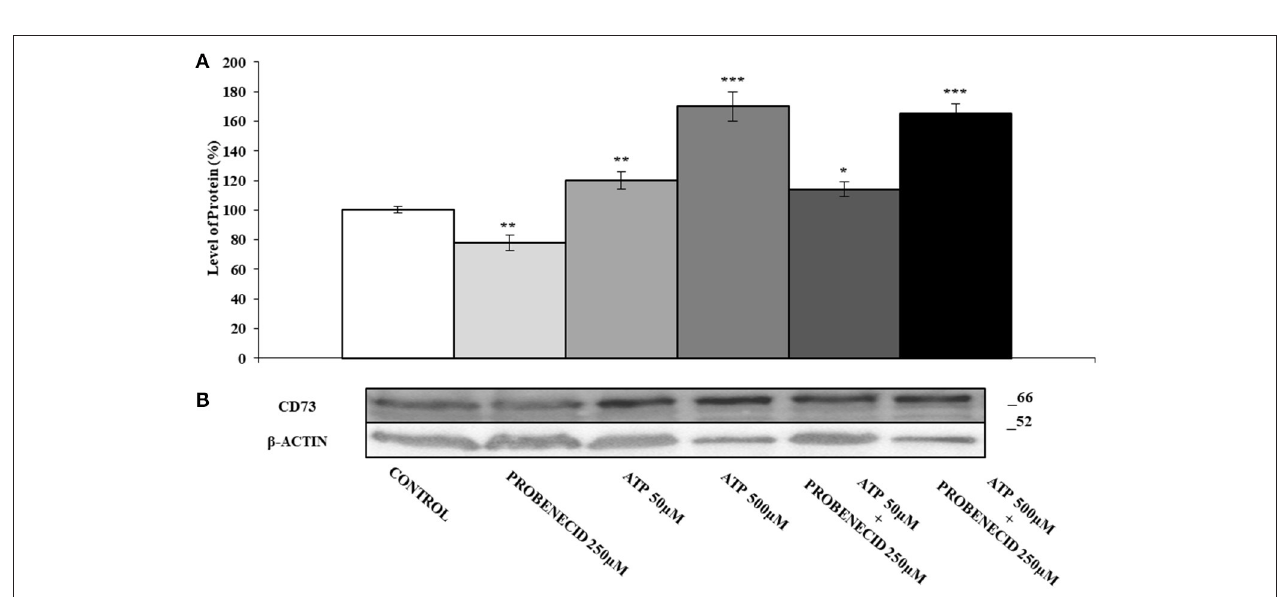
FIGURE 3 | The effects of ATP on CD73 protein expression, with or without Probenecid. (A,B) Densitometric analysis and representative western blot of CD73 in three independent experiments (means ± SD). * p < 0.05, ** p < 0.01, *** p < 0.001, Student’s t -test. β -actin was used as a loading control. All the experiments were performed treating HepG2 cells with ATP and/or Probenecid for 48h. DMSO-treated cells were used as control.